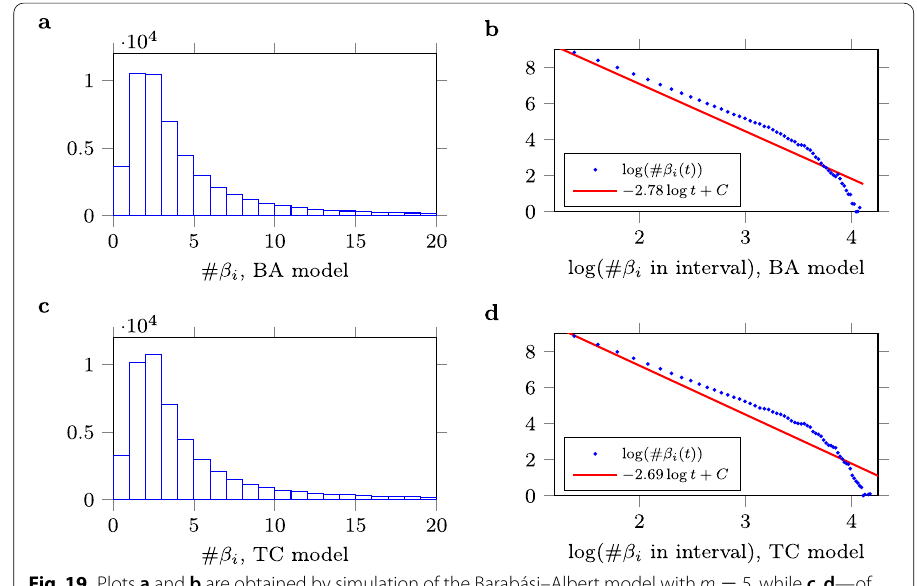
Fig. 19 Plots a and b are obtained by simulation of the Barabási–Albert model with m = 5 , while c , d —of the Triadic Closure model with m = 5 , p = 0.75